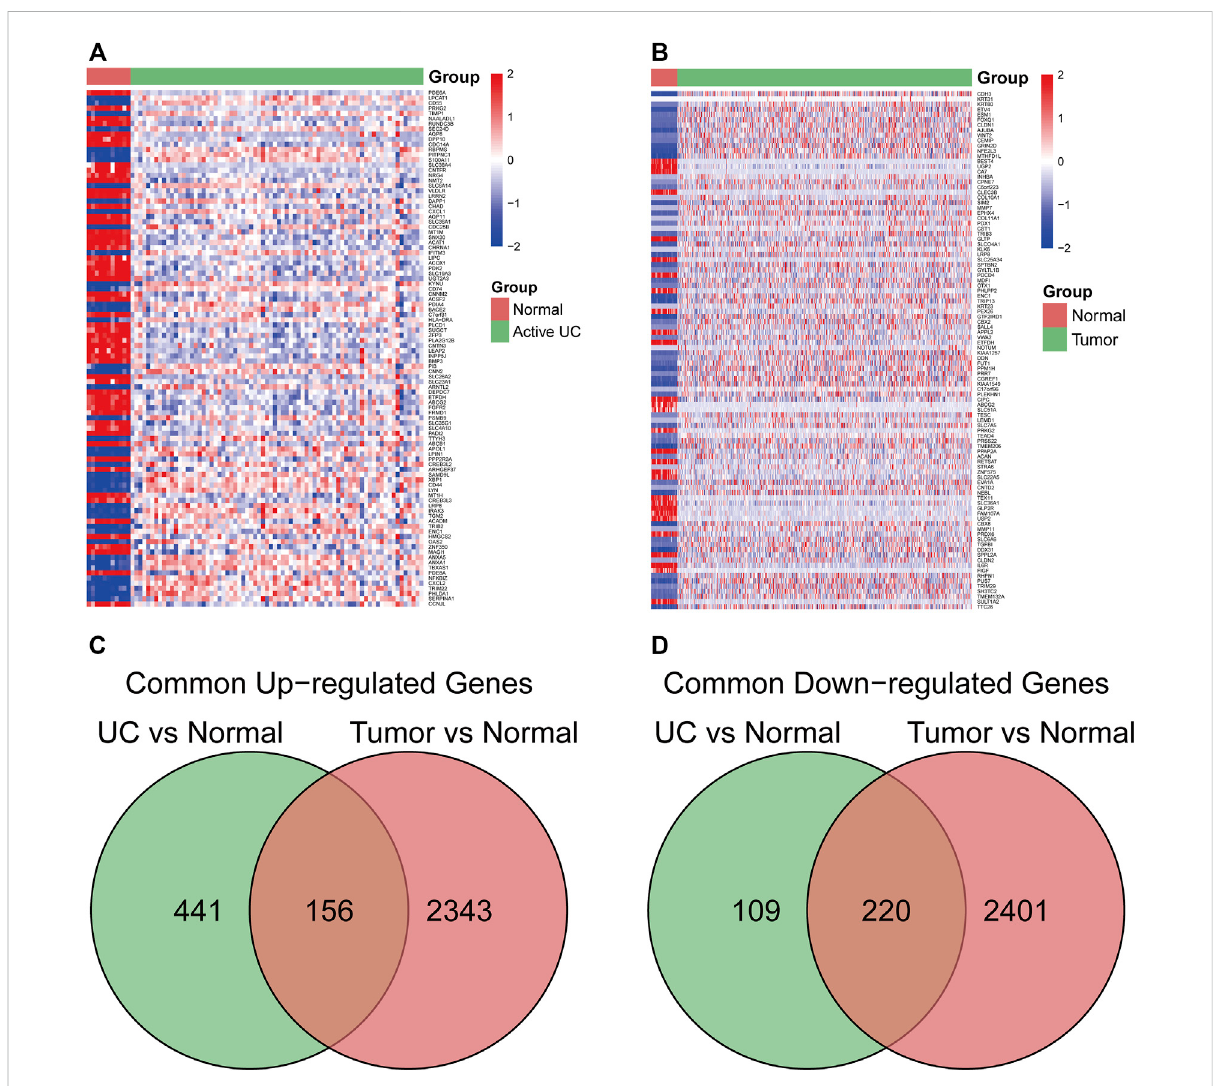
FIGURE 2 The common differentially expressed genes (DEGs) between ulcerative colitis (UC) and colorectal cancer (CRC). (A) heatmap of the top 100 DEGs in the UC dataset. (B) heatmap of top 100 DEGs in the CRC dataset. (C) common upregulated DEGs in UC and CRC. (D) common downregulated DEGs in UC and CRC. Abbreviation: DEGs, Differentially expressed genes; UC, ulcerative colitis; CRC, colorectal